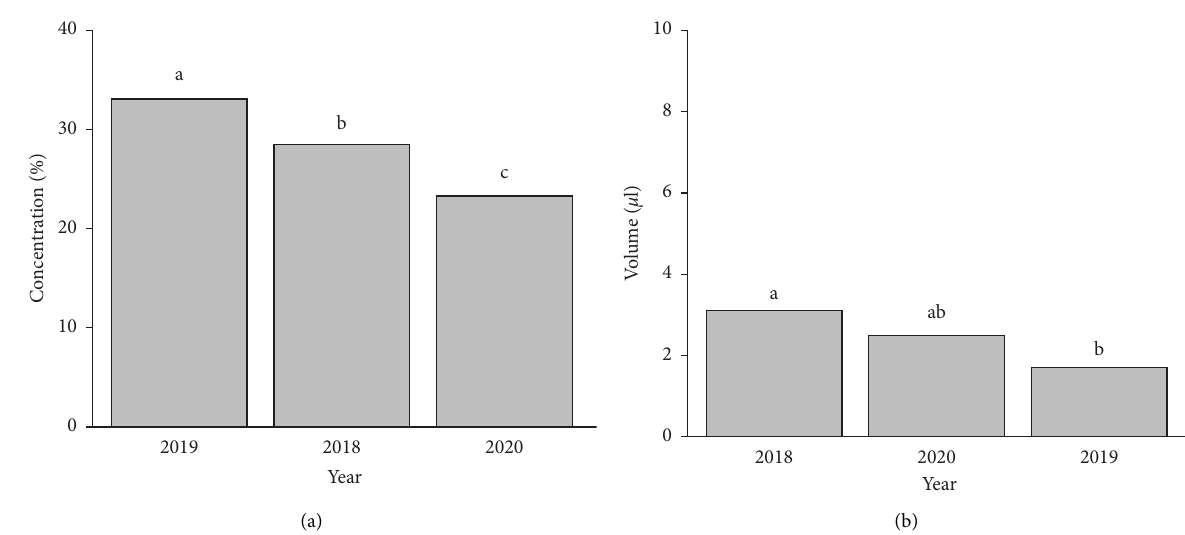
Figure 3: Nectar concentration (a) and volume (b) of Hygrophila auriculata from 2018 to 2020 years in southwest Shewa Zone,